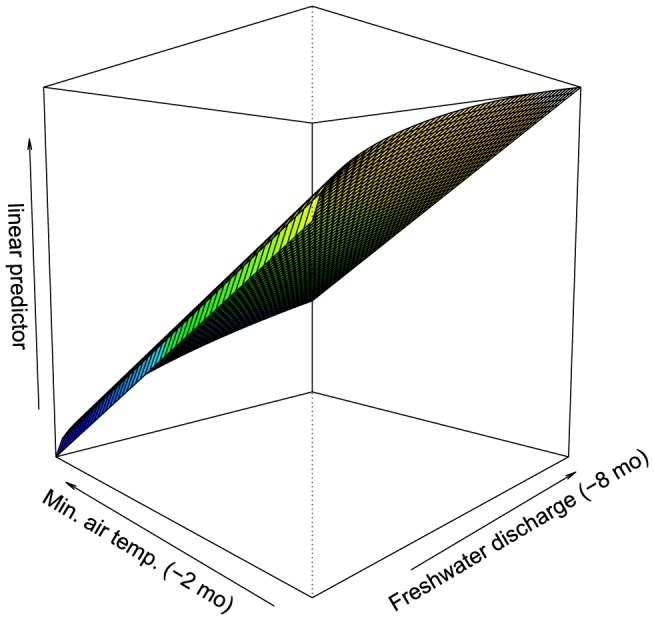
Final model of inshore dolphin natural mortality in response to mean minimum air temperature (°C, lagged by 2 months) and freshwater discharge (m3s−1, lagged by 8 months and square-root transformed).A Poisson error and log-link function were used for this relationship, the response surface is on the scale of the linear predictor.